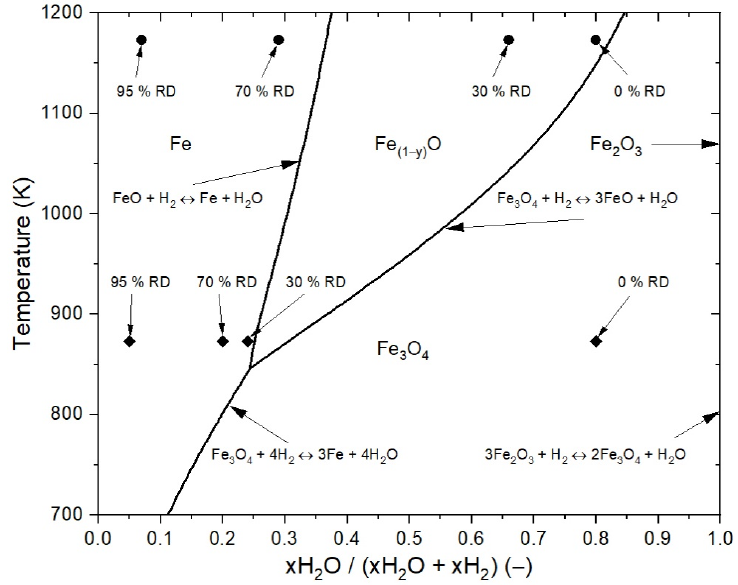
Figure 5. Baur–Glaessner diagram including the process conditions for 873 and 1173 K.